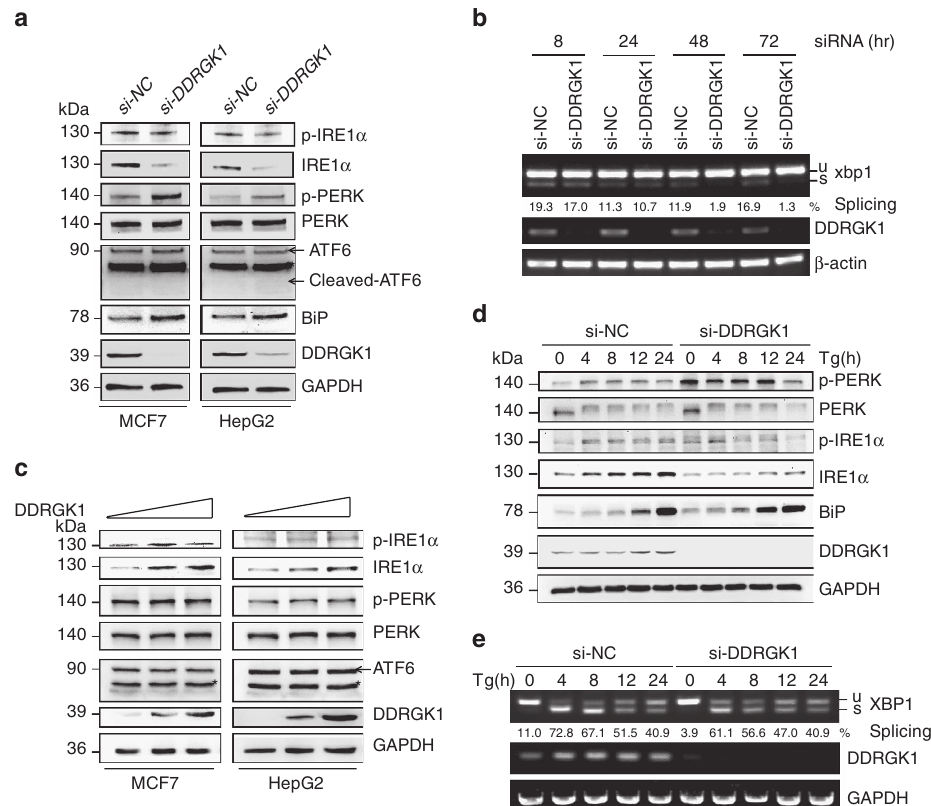
Figure 3 | DDRGK1 modulates the UPR. ( a ) MCF7 and HepG2 cells were transfected with either control siRNA or siRNA targeting DDRGK1 for 72h. The protein levels of p-IRE1 a , IRE1 a , p-PERK, PERK, ATF6 and BiP were determined by western blot. ( b ) MCF7 cells were transfected with control siRNA or siRNA against DDRGK1, and the cells were harvested at the indicated times for RT-PCR analysis of XBP-1 splicing. ( c ) MCF7 and HepG2 cells were transfected with control or DDRGK1 vectors at various doses for 36h. The protein levels of p-IRE1 a , IRE1 a , p-PERK, PERK and ATF6 were determined by western blot. ( d ) MCF7 cells were transfected with siRNA control or siRNA targeting DDRGK1 for 72h. The cells were collected for western blot after treatment with 2.5 m M Tg at the indicated times. ( e ) RT-PCR analysis of XBP-1 splicing in d . *Represents non-specific